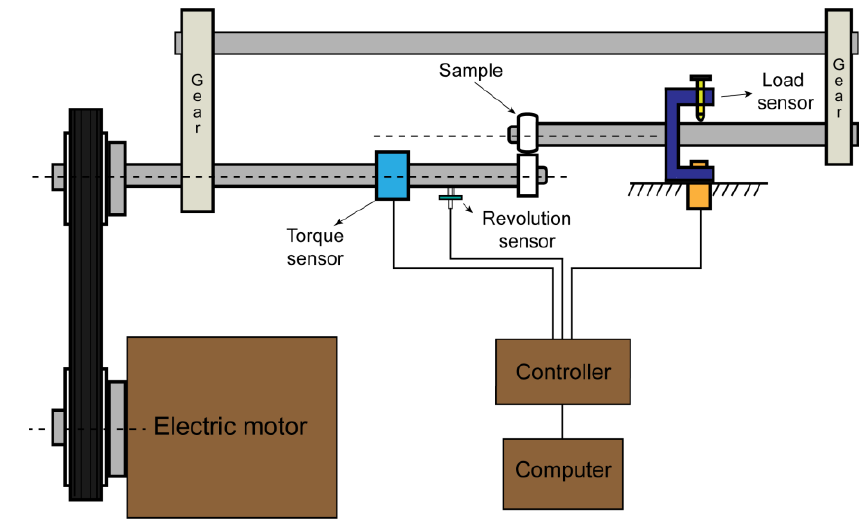
Table 3. Test parameters and calculation results of contact stress.